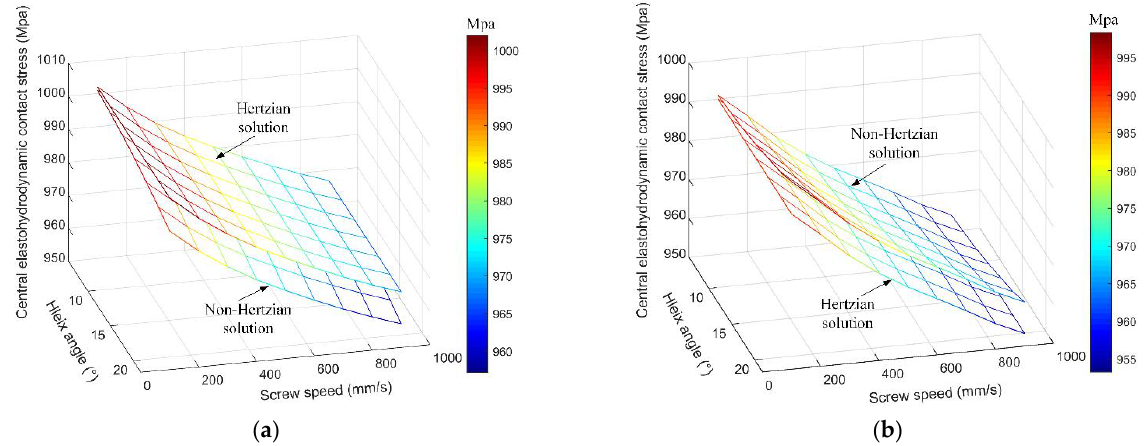
Figure 12. Comparison of the elastohydrodynamic stress between the Hertzian solution and non-Hertzian solution under different screw speeds. ( a ) Central elastohydrodynamic contact stress of point A . ( b ) Central elastohydrodynamic contact stress of point B .